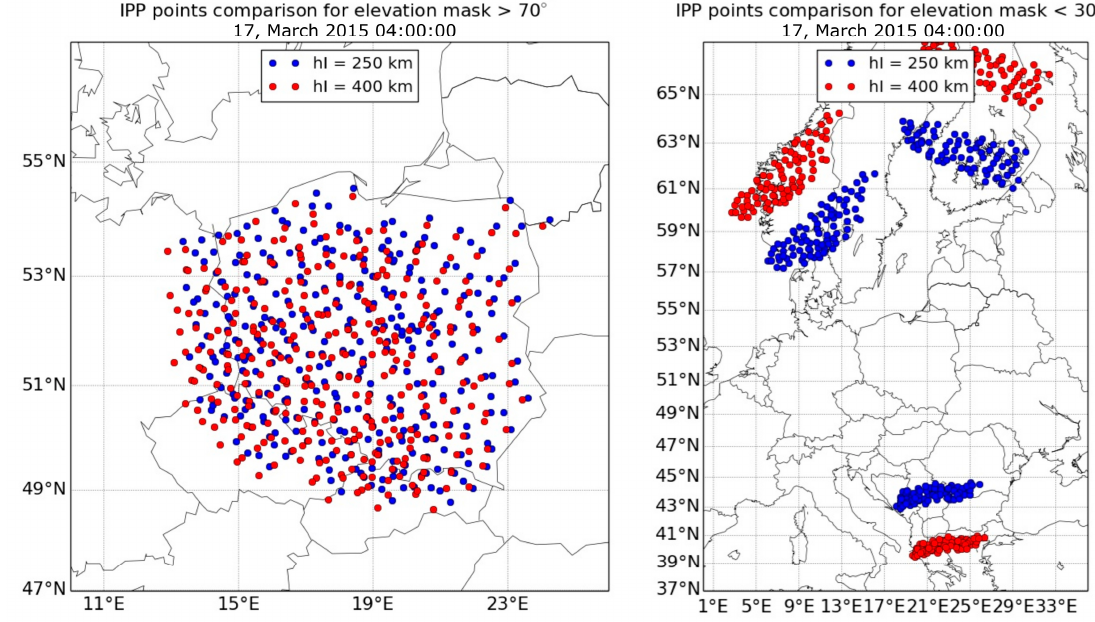
Figure 1. Comparison of ionospheric pierce points (IPPs) distribution for 250 km (blue) and 400 km (red) ionospheric layer heights and for elevation masks >70° ( left , one satellite) and <30° ( right , three satellites).